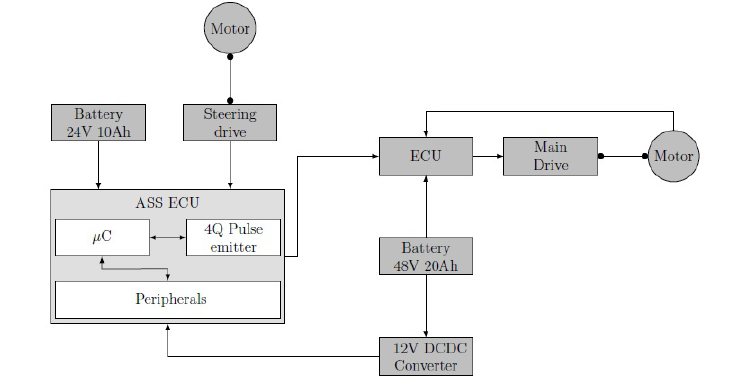
Fig. 1. Schematic of electric system of the autonomous Quad MQOne